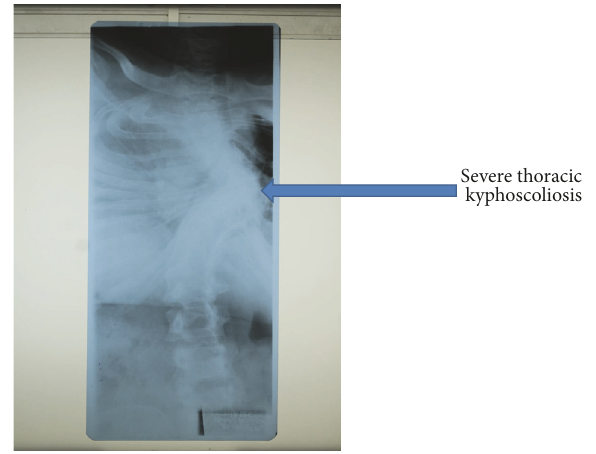
Figure 2: Chest X-ray showed severe kyphoscoliosis in a 25-year- old male with Prader-Willi